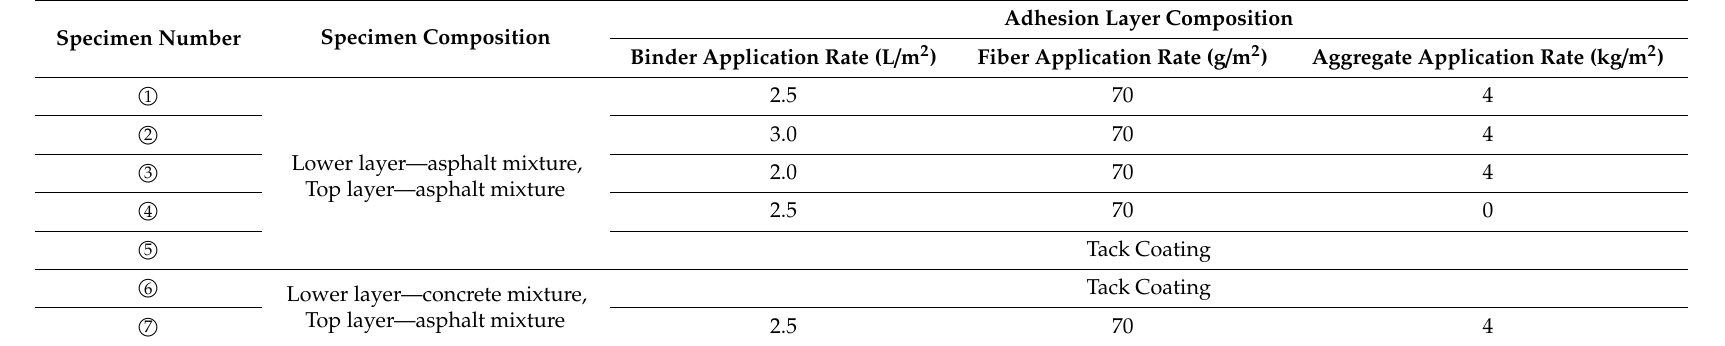
Table 2. Fiber-reinforced, stress-absorbing membrane interlayer (F-SAMI)